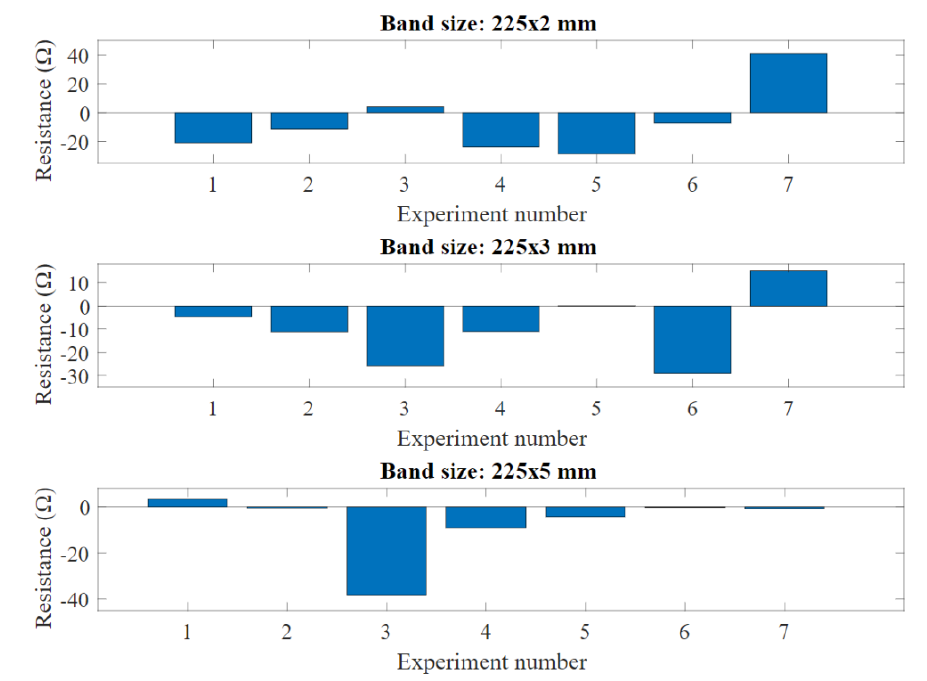
Figure 15. The resistance changes for all bands used in the